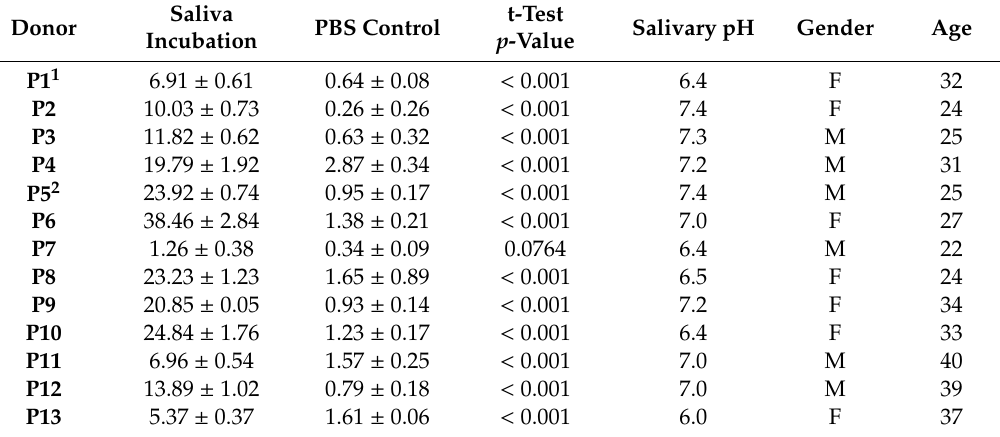
Table 1. Percentage (mean ± SEM, n = 3) of doubly-fluorescent foci in cell monolayers inoculated with a 1:1 mixture of vesicular stomatitis virus (VSV)-mCherry and VSV-eGFP with or without (PBS) prior incubation in